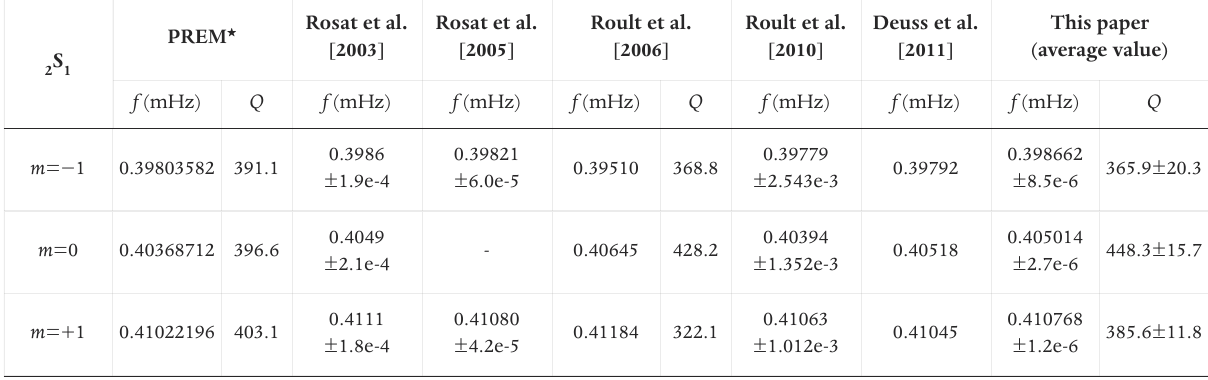
S . (*): from Millot-Langet et al. [2003], Roult et al. 2 1